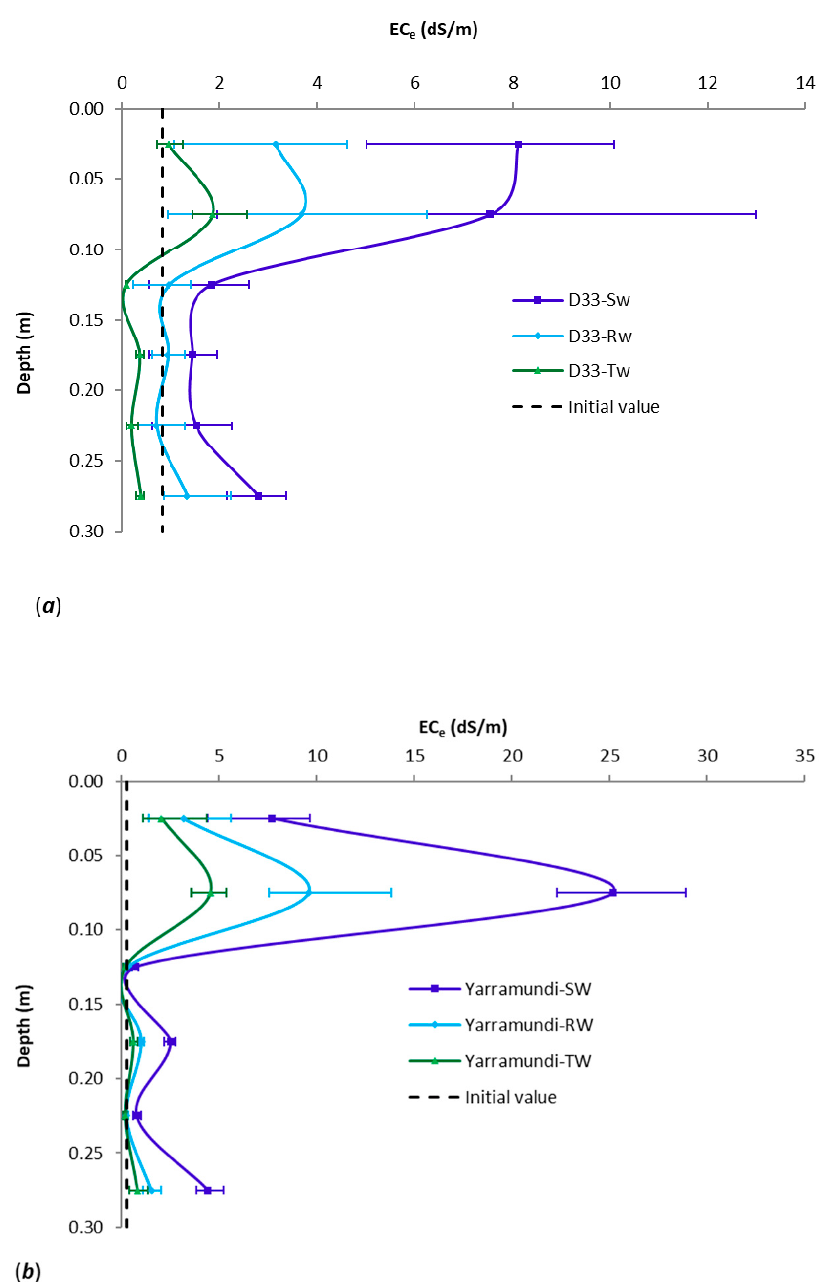
Figure 6. Salinity profile in terms of EC e using TW, RW, and SW as irrigation water in ( a ) D33 paddock soil columns and ( b ) Yarramundi paddock soil columns after the study period of 330 days. The dotted line and error bars show the initial EC e and the minimum and maximum value of EC e , respectively.